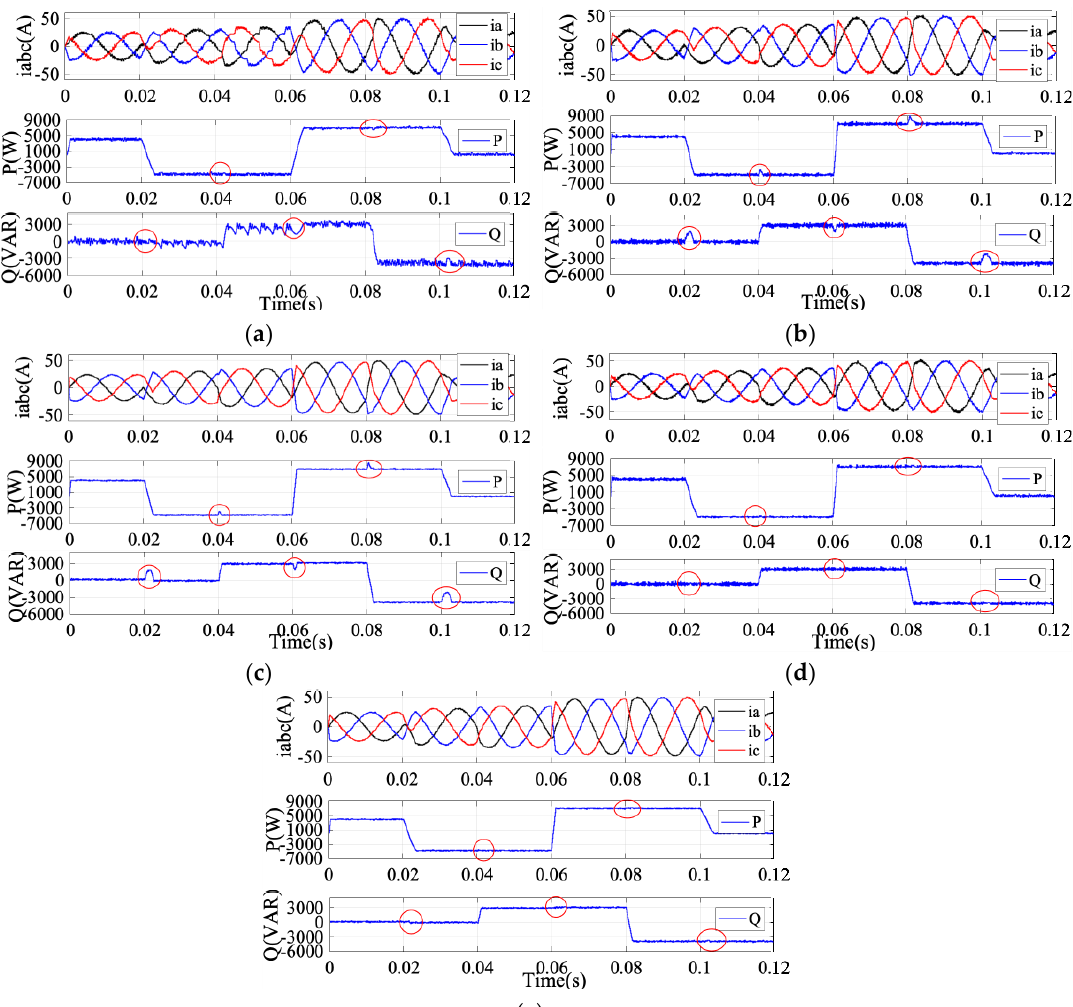
Figure 6. Dynamic performance. From top to bottom, AC voltage, three-phase currents, active power, and reactive power. (a) CDPC. (b) CMPC-I. (c) CMPC-II. (d) MMPC-I . (e) MMPC-II.